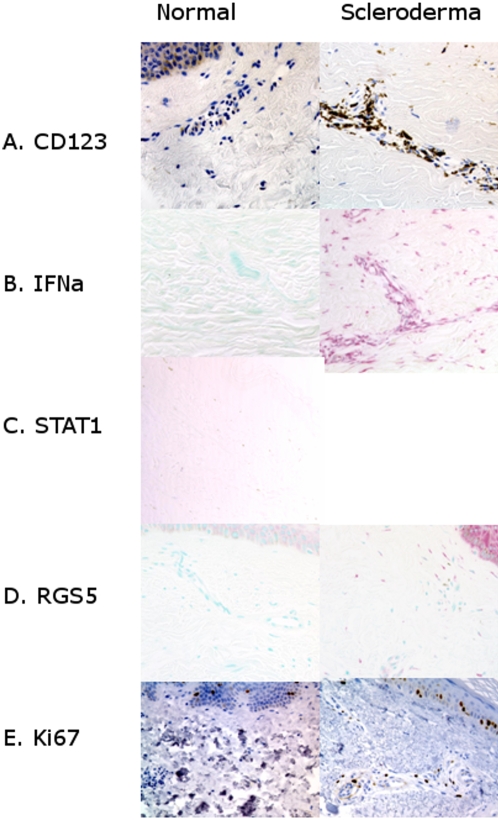
Non-Angiogenic Phenotype in Scleroderma Compared to Normal Controls.A) There was increased staining in CD123 in perivascular cells in the superficial horizontal plexus in skin biopsies from scleroderma patients compared with normal controls. B) Interferon a (IFNa) in situ hybridization exhibited a robust signal in scleroderma but was absent from controls. C.) Nuclear staining of phosphorylated STAT1 in scleroderma provided evidence of active interferon signaling, with STAT1 phosphorylation, dimerization and translocation to nucleus in response to interferon a. D.) RGS5, a marker of pericytes and arterial smooth muscle had increased mRNA expression in scleroderma in a perivascular distribution. E.) Ki67 a marker of cell cycle, showed no sign of Ki67 labeling of the endothelial cells in either normal controls or scleroderma. There was an increase in Ki67 positive perivascular cells in scleroderma.